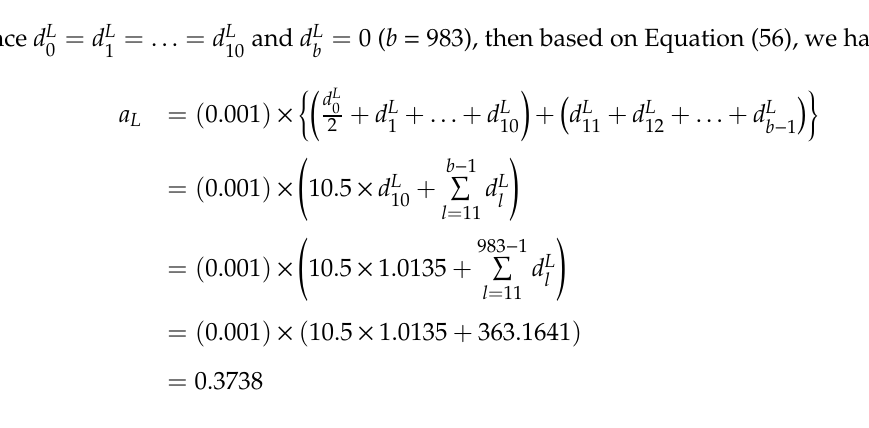
= 4.125 and η − ( x ) with C − p ∗ = 4.125 and ( ) x η − with qi qi